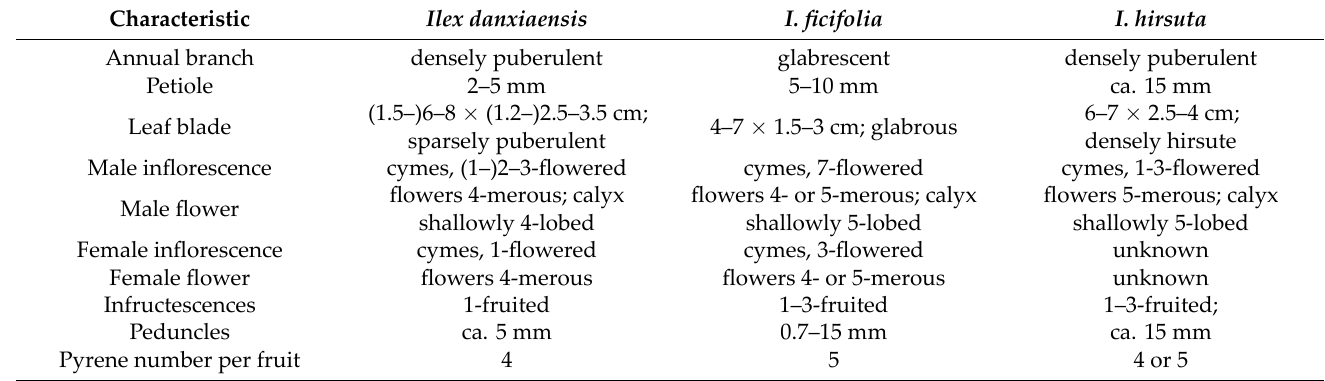
Table 1. Morphological comparisons among Ilex danxiaensis and its morphologically similar